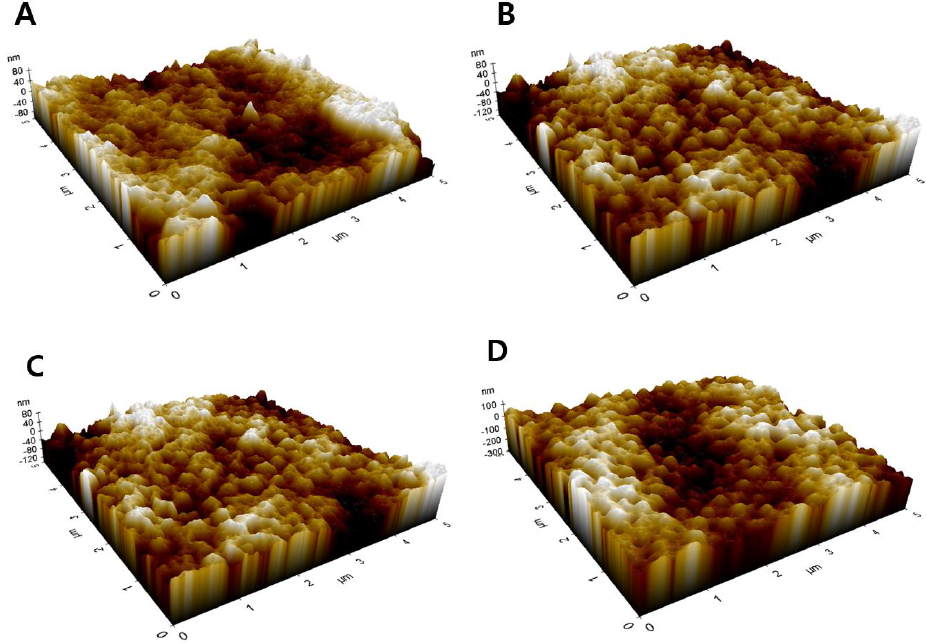
Figure 12. AFM images of fabricated membranes: ( A ) (S3) Water; ( B ) (S5) Water (90%) + EtOH (10%); ( C ) (S6) Water (80%) + EtOH (20%); and ( D ) (S7) Water (70%) + EtOH (30%). Table 5. Roughness parameters of the prepared membranes. Membrane